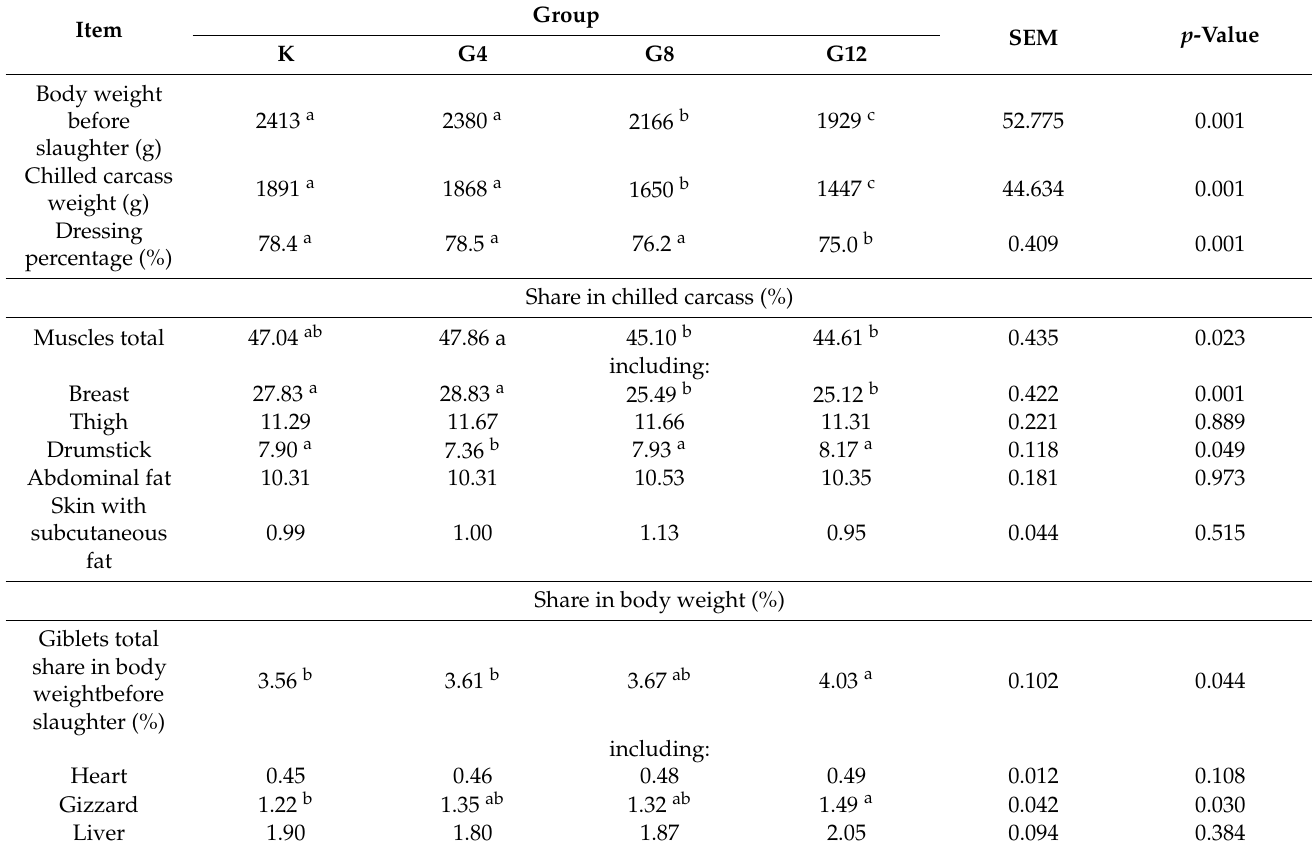
Table 6. Carcass composition of broiler chickens fed graded levels of guar